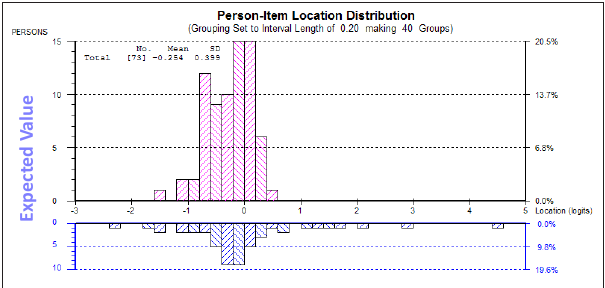
FIGURE 6: The person-item location distribution prior to rescoring.